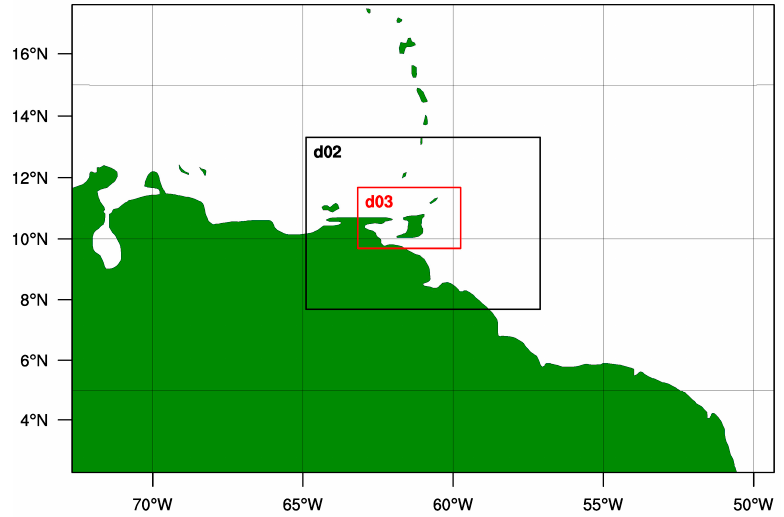
Figure 1. Numerical domain under consideration. The outermost boundaries denote the parent grid, d02 and d03 are the nested domains, d03 encompasses the area of interest, Trinidad and Tobago.